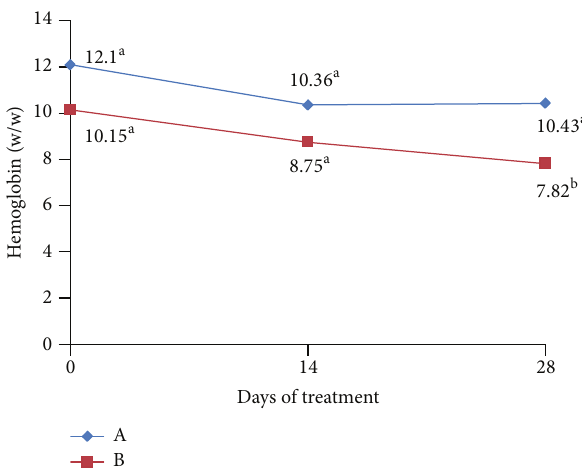
of animal groups assessed. a , b different letters represent significant differences in statistical terms ( 𝑃 < 0.05 ). Reference values: 14– 18g (w/w).